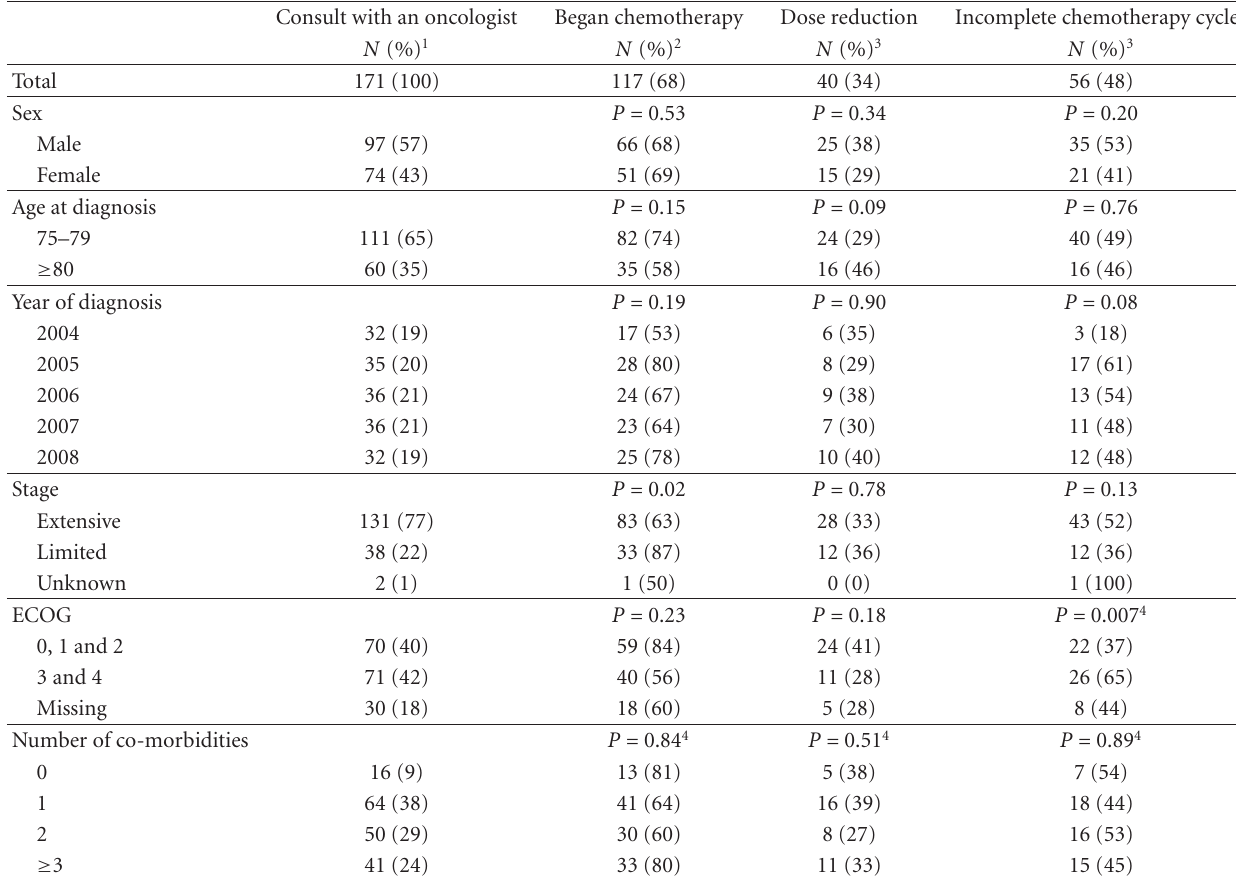
Table 2: Association of demographic/clinical characteristics and receipt/tolerance of chemotherapy of patients diagnosed with SCLC aging 75 years and older who had an oncologist-consult.